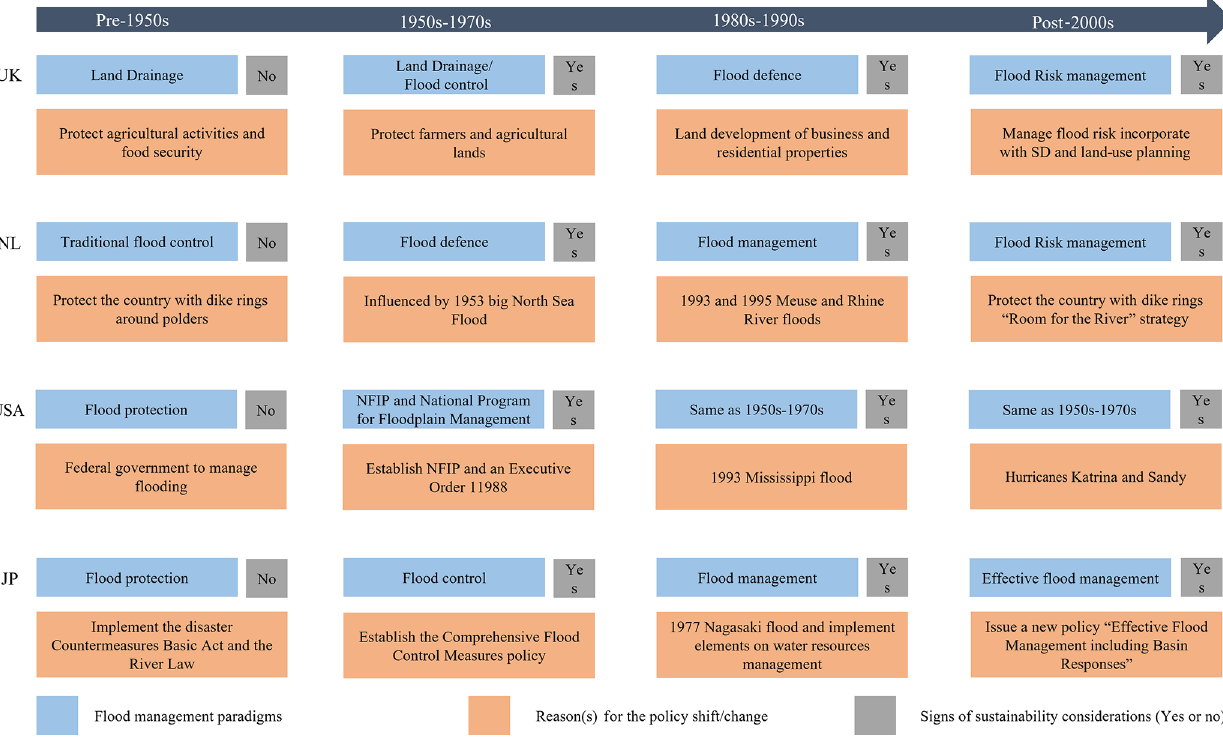
Figure 4. Flood management paradigms and major changes towards